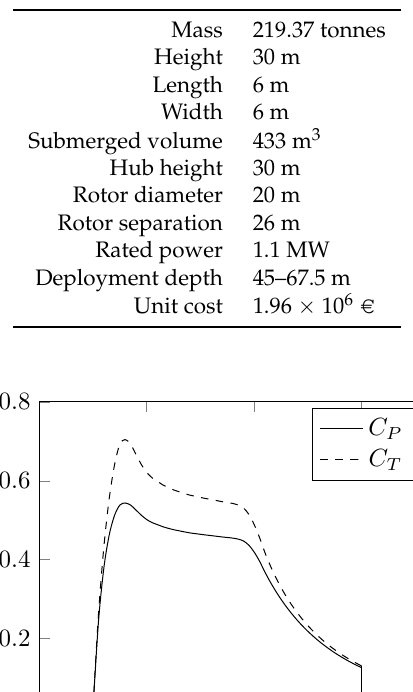
Table 3. Significant characteristics of the RM1 device.